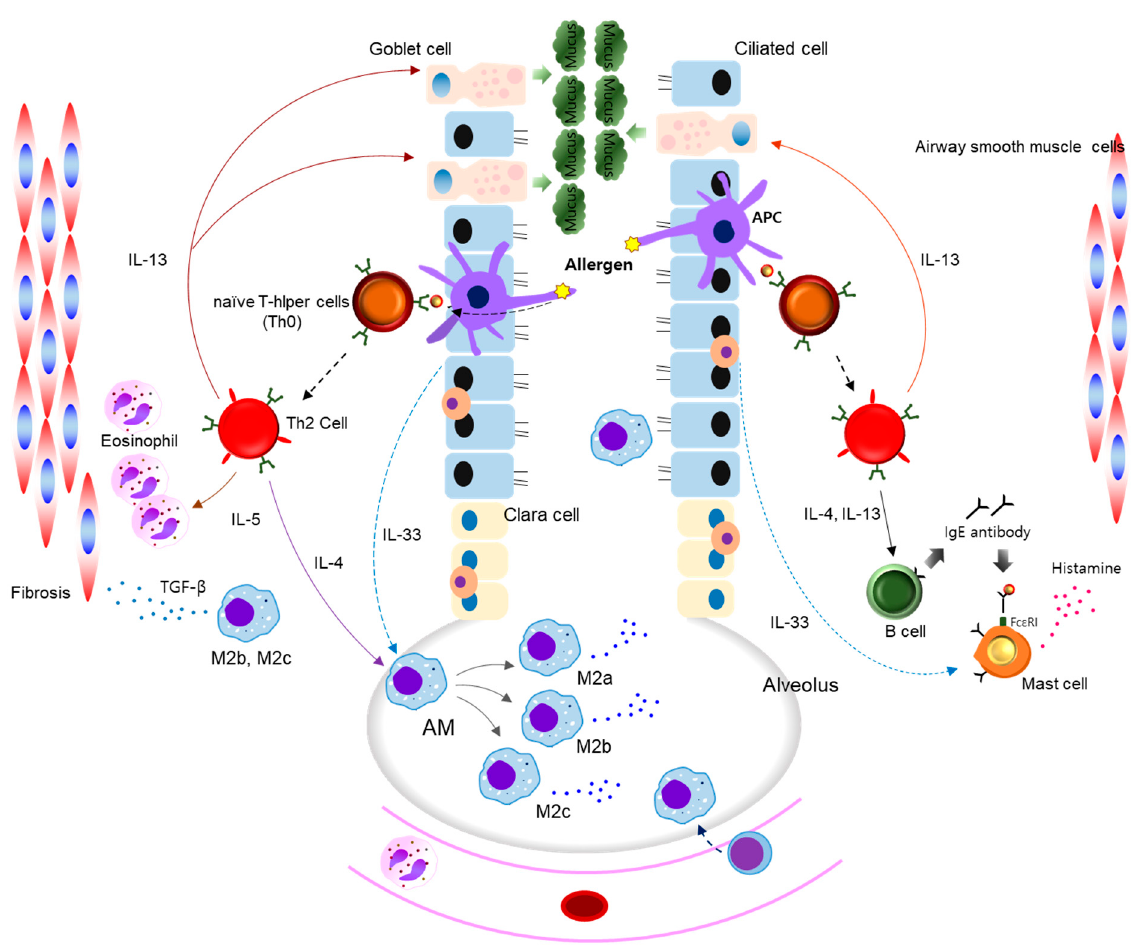
Figure 3. The role of macrophages in allergic asthma. Antigen-presenting cells (APCs) recognize allergens and initiate the allergic cascade. Under these conditions, naïve CD4+ T cells differentiate into Th2 cells. Th2 cell-mediated IL-4 and IL-13 generation lead to the induction of M2 phenotype macrophages. M2 macrophages are classified into subdivisions (M2a, M2b, and M2c). Macrophage-derived inflammatory cytokines and chemokines promote eosinophil recruitment and allergic airway inflammatory responses. Macrophage-derived TGF- β also promotes the proliferation of airway smooth muscle cells and fibrosis. IL-5 induces eosinophil influx and activation. Eosinophil-derived CCL11 leads to eosinophil recruitment. IL-13 induces goblet cell hyperplasia and mucus hypersecretion. This increased secretion contributes to the airflow obstruction. Airway epithelial cell-derived IL-33 promotes levels of M2 macrophages and stimulates mast cells which, in turn, leads to the generation of histamine and leukotrienes. This series of processes leads to airway inflammation and remodeling in addition to mucus overproduction in allergic